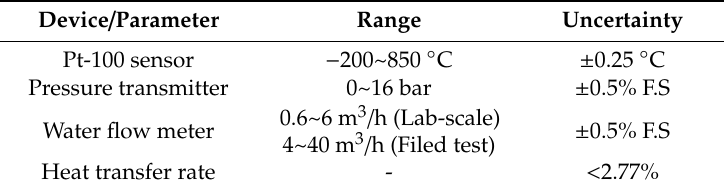
Table 2. List of measuring devices, specifications, and